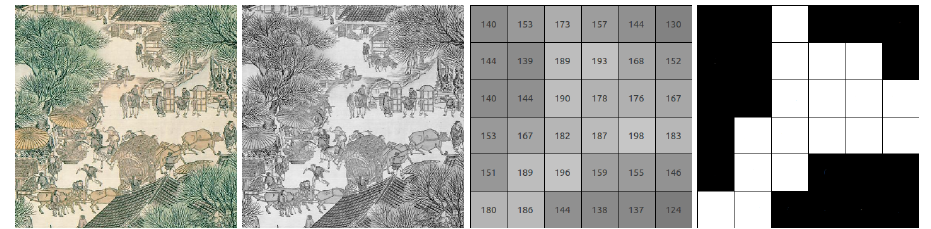
Figure 4. ArPico Marker Conversion